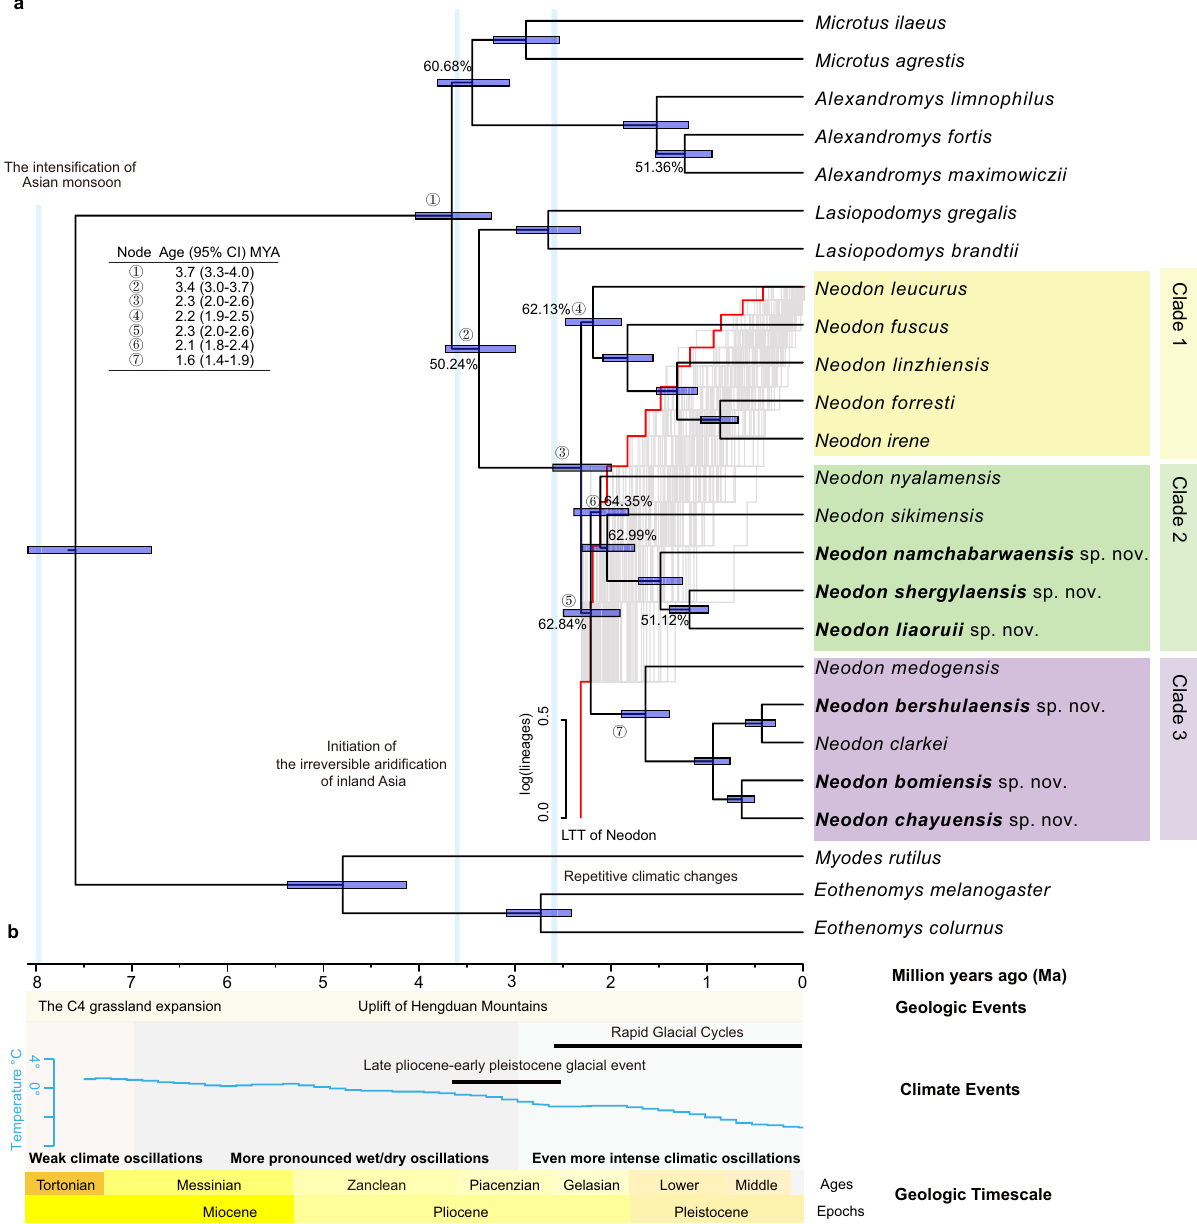
Fig. 3 Divergence time tree, diversi fi cation patterns, the frequency of the non-main topologies and photos of Neodon . a Divergence time-tree with the Astral branch supports values of the nuclear gene tree are shown near the branches. New species denoted in bold. Clades of Neodon indicated by shading with different colours on the tree (Clade 1: yellow; Clade 2: green; Clade 3: purple). The blue rectangles at the nodes represent 95% con fi dence intervals of the corresponding estimated divergence times. Branches with high non-main topology occurrence frequencies (>50%) are marked with the content number. Log-lineage-through-time (LTT) plots for Neodon estimated from the time-calibrated phylogeny (red curve), and the semilucent red dashed line indicates the null distribution under a Yule process. b The divergence time, geologic timescale, geologic events and climate events are shown at the bottom of the fi